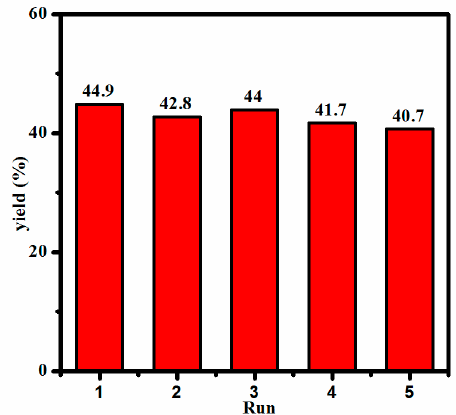
Figure 6. Catalytic oxidation of α -phenethyl alcohol by 1 in different runs.